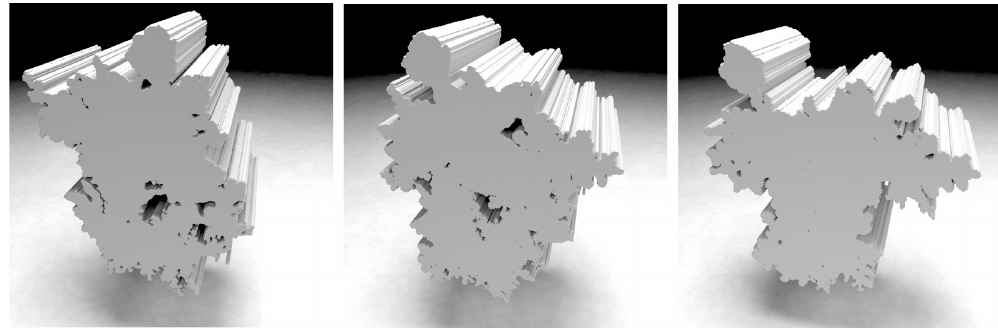
Fig. 6. Example of the triplet form for an extruded ice flake used for input to DDSCAT (hydrometeor B in Fig. 5). Displays are rendered with Monte Carlo ray tracing, based on idealized surface material properties, using a Metropolis sampling method.